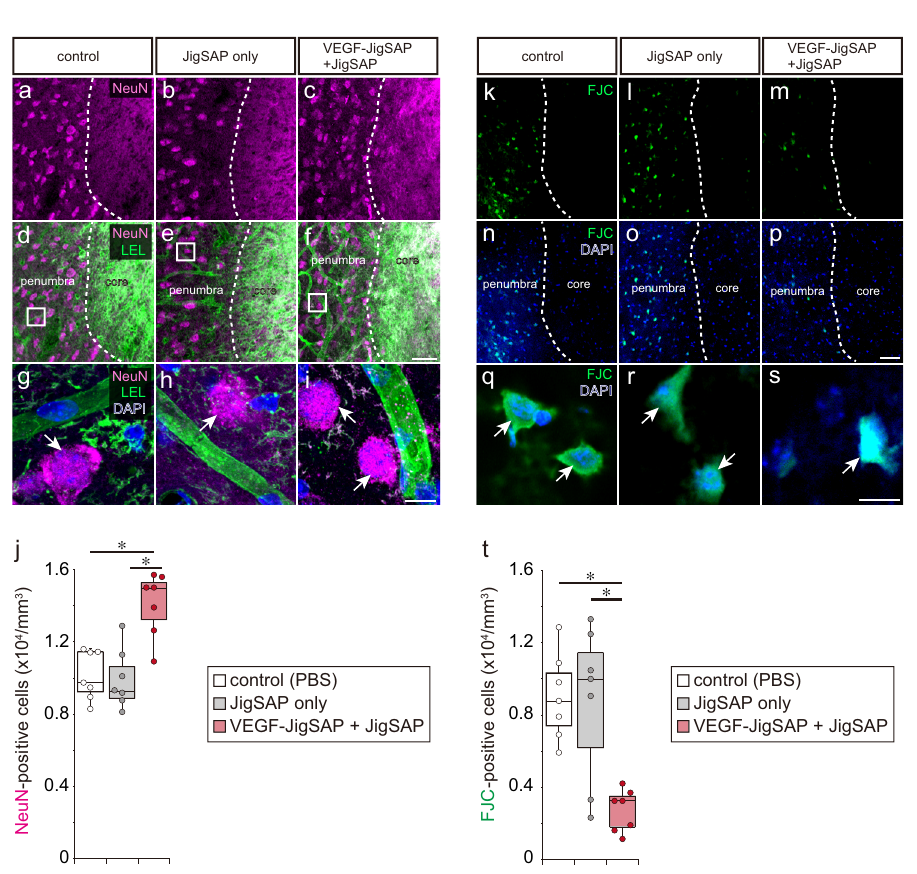
Fig. 5 Neuroprotection of a mouse stroke model by a single injection of JigSAP nano fi bers incorporating VEGF-JigSAP proteins. a – f NeuN (magenta) ( a – c ) and NeuN (magenta)/LEL (green) ( d – f ) images at the border of the injured core and the penumbra. g – i High magni fi cation images of NeuN (magenta), LEL (green), and DAPI (blue) at the penumbra. j Cell scoring of NeuN-positive cells at the penumbra. k – p FJC (green) ( k – m ) and FJC (green)/ DAPI (blue) ( n – p ) images at the border of the injured core and the penumbra. q – s High magni fi cation images of FJC (green)/DAPI (blue) at the penumbra. t Cell scoring of NeuN-positive cells at the penumbra. For cell counting, NeuN- and FJC-positive cells were counted from the non-neural lesion borders to 200 μ m away. Scale bars: 10 μ m. * P < 0.05 (Student ’ s t-test against VEGF-JigSAP + JigSAP, two-sided). n = 7. Box-plot elements show: center line, median; box limits, 25 and 75 percentiles; whiskers, (Q1/4 – 1.5IQR) and (Q3/4 – 1.5IQR). Source data are provided as a Source Data fi le. Abbreviations; FJC (Fluoro-Jade C), VEGF (vascular endothelial growth factor), JigSAP (jigsaw-shaped self-assembling